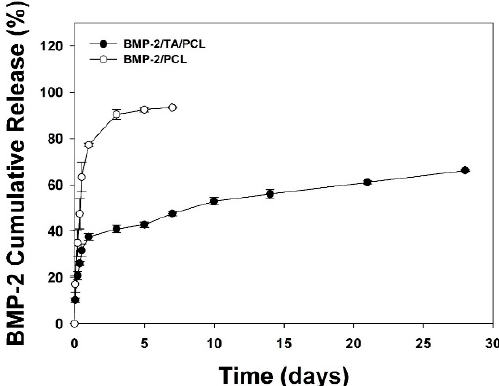
Figure 4. In vitro cumulative BMP-2 release profiles for the BMP-2/PCL and BMP-2/TA/PCL scaffolds.